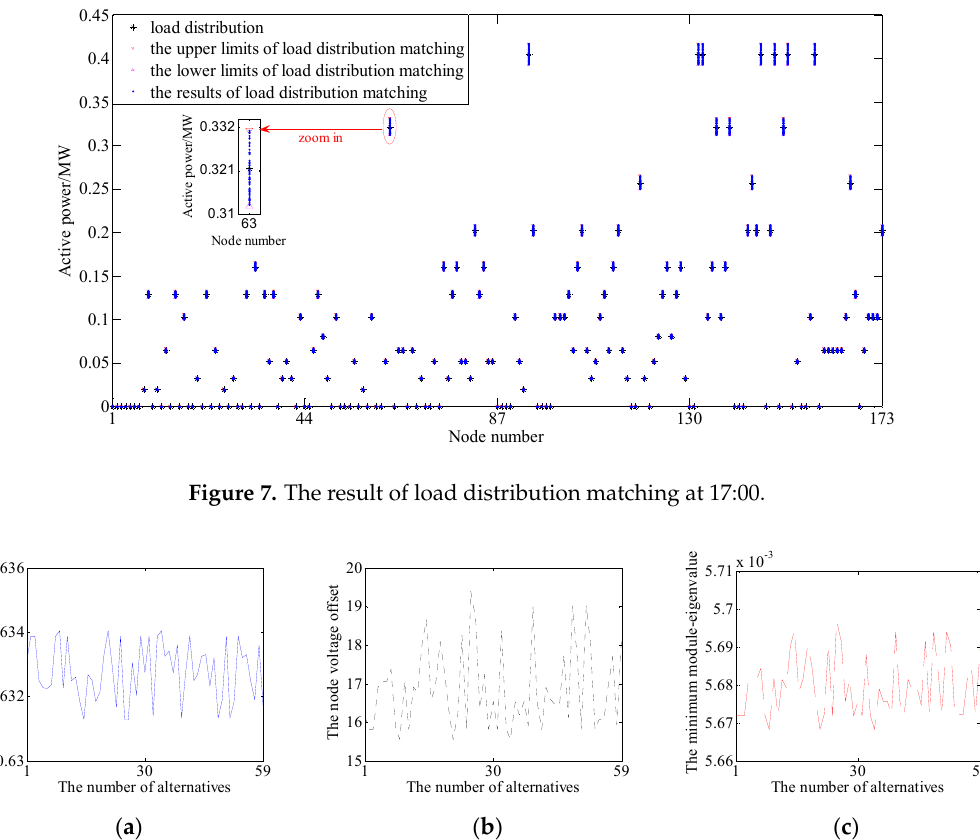
Figure 8. The evaluation indexes of alternatives: ( a ) the network loss; and ( b ) the node voltage offset; ( c ) the minimum module-eigenvalue.